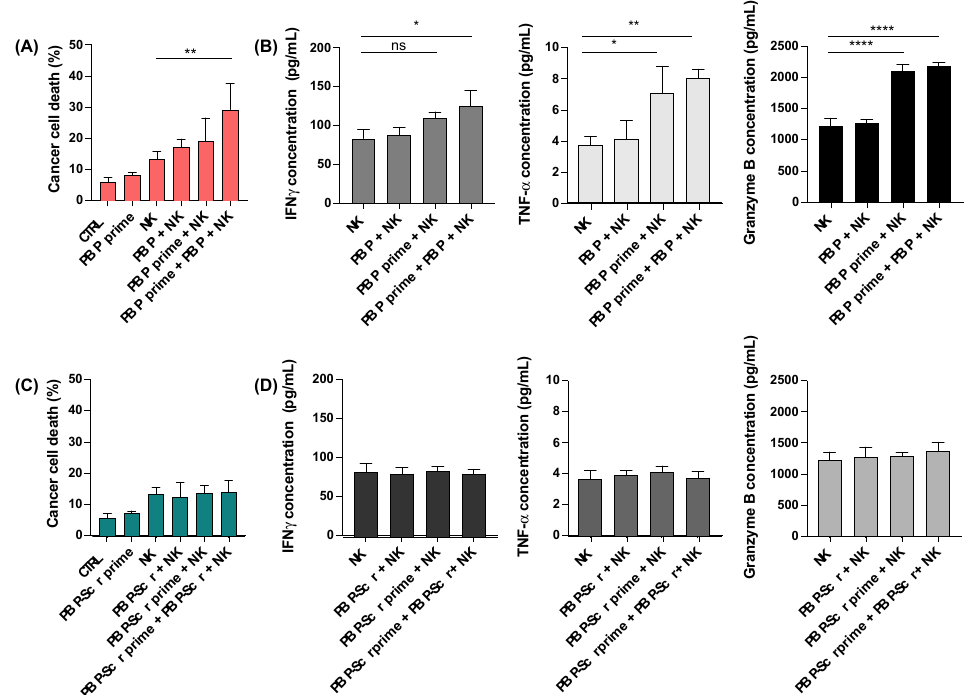
Figure 2. PBP or PBP-Scr effects on anti-cancer activity of NK cells. Enhanced anti-cancer activity of NK cells after PBP priming of cancer cells is accompanied by increased cytokine secretion by NK cells. ( A , C ) Cytotoxic activity of NK cells against B16F10 cancer cells with or without 48h PBP or PBP-Scr priming (“PBP prime” or “PBP-Scr prime”) and/or co-treatment (“PBP” or “PBP-Scr”). ( B , D ) Cytokine (IFN- γ , TNF- α , and granzyme B) concentrations determined by ELISA in the culture supernatants from ( A , C ), respectively. One-way ANOVA, Tukey test was performed for statistical analysis (* p < 0.03, ** p < 0.002, **** p < 0.0001, and ns = non-significance) and n = 3.